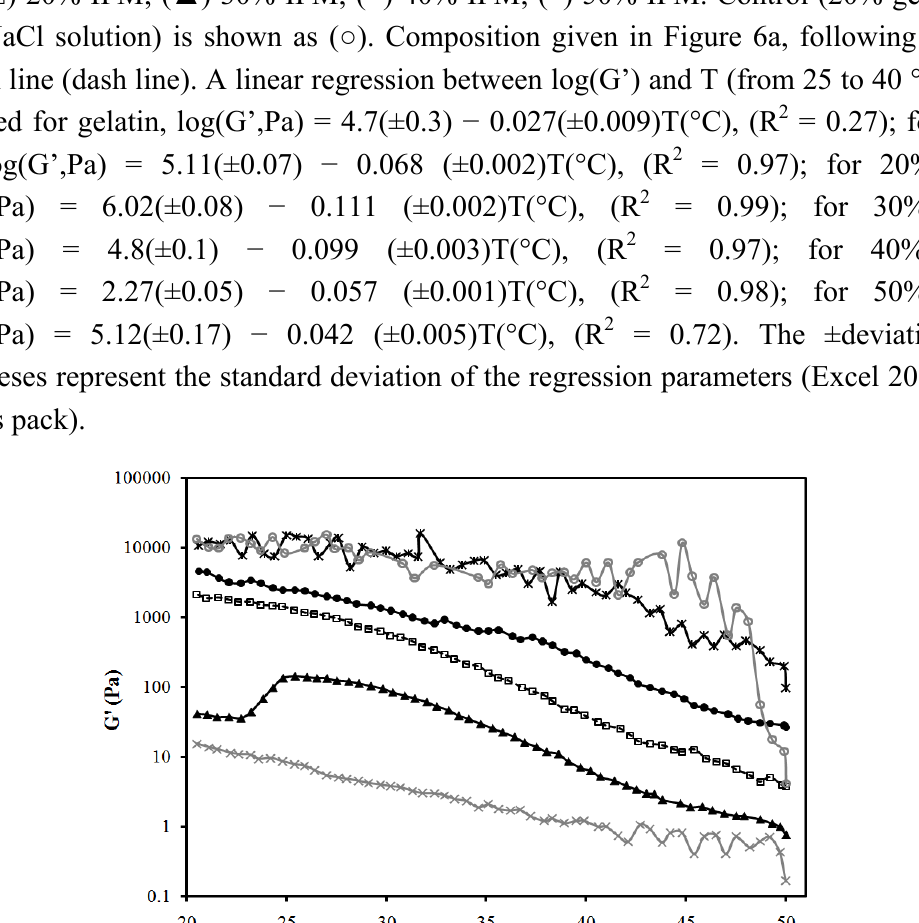
Figure 7. Elastic modulus vs. temperature profile for the systems of Figure 6b: ( ● )